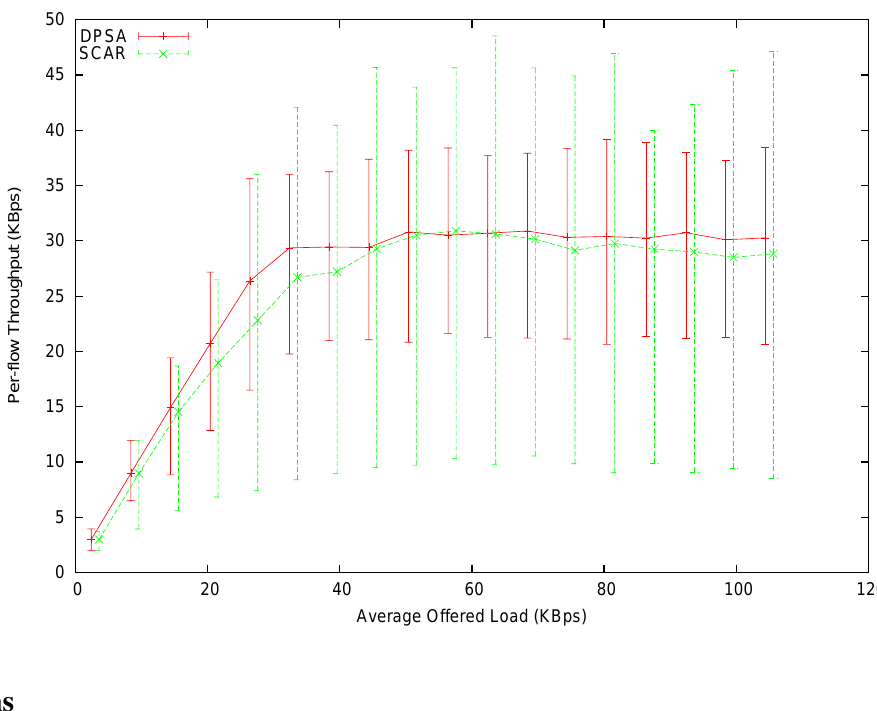
Figure 14. Per-flow throughput of Experiment